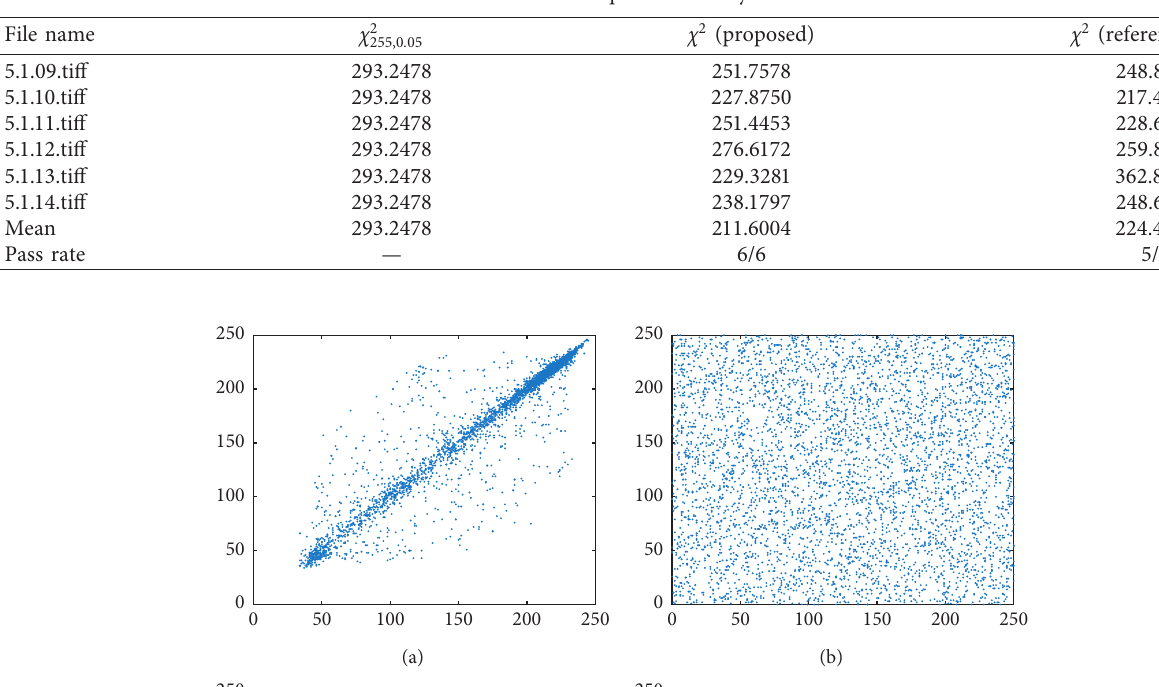
Figure 7: Histogram analysis: (a, d, g) the histograms of plain images 5.1.11.tiff, 5.1.12.tiff, and 5.1.13.tiff; (b, e, h) the histograms of the respective encrypted results; (c, f, i) the histograms of the respective recovered images. Table 1: Chi-square test